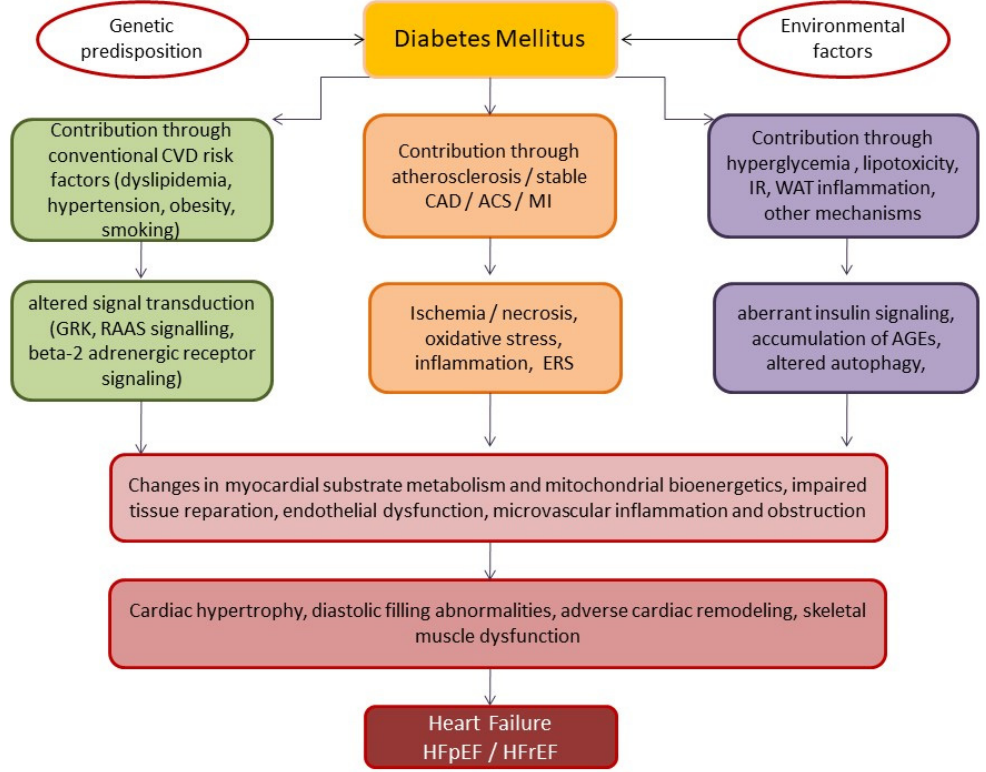
Figure 1. Underlying pathophysiological mechanisms contributing to the development of HF in patients with DM. Abbreviations: ACS, acute coronary syndrome; AGEs, advanced glycated end- products; CAD, coronary artery disease; CVD, cardiovascular disease; GRK, g-protein receptor kinase; ERS, endoplasmic reticulum stress; MI, myocardial infarction; HF, heart failure; HFrEF, heart failure with reduced ejection fraction; HFpEF, heart failure with preserved ejection fraction; IR, insulin resistance; RAAS, renin–angiotensin–aldosterone system; WAT, white adipose tissue.